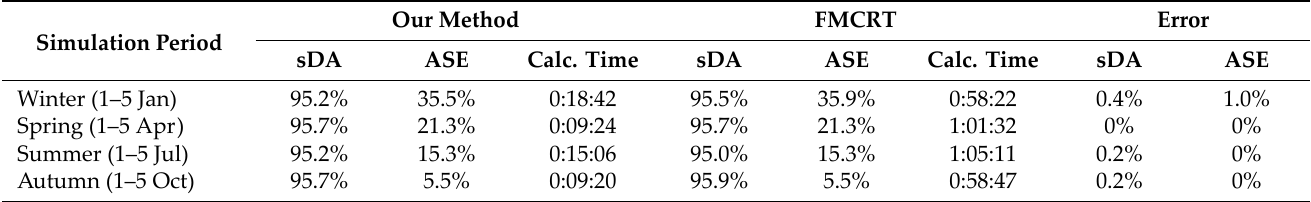
Table 5. Comparison of our method with FMCRT. The third verification scene (Figure 5).